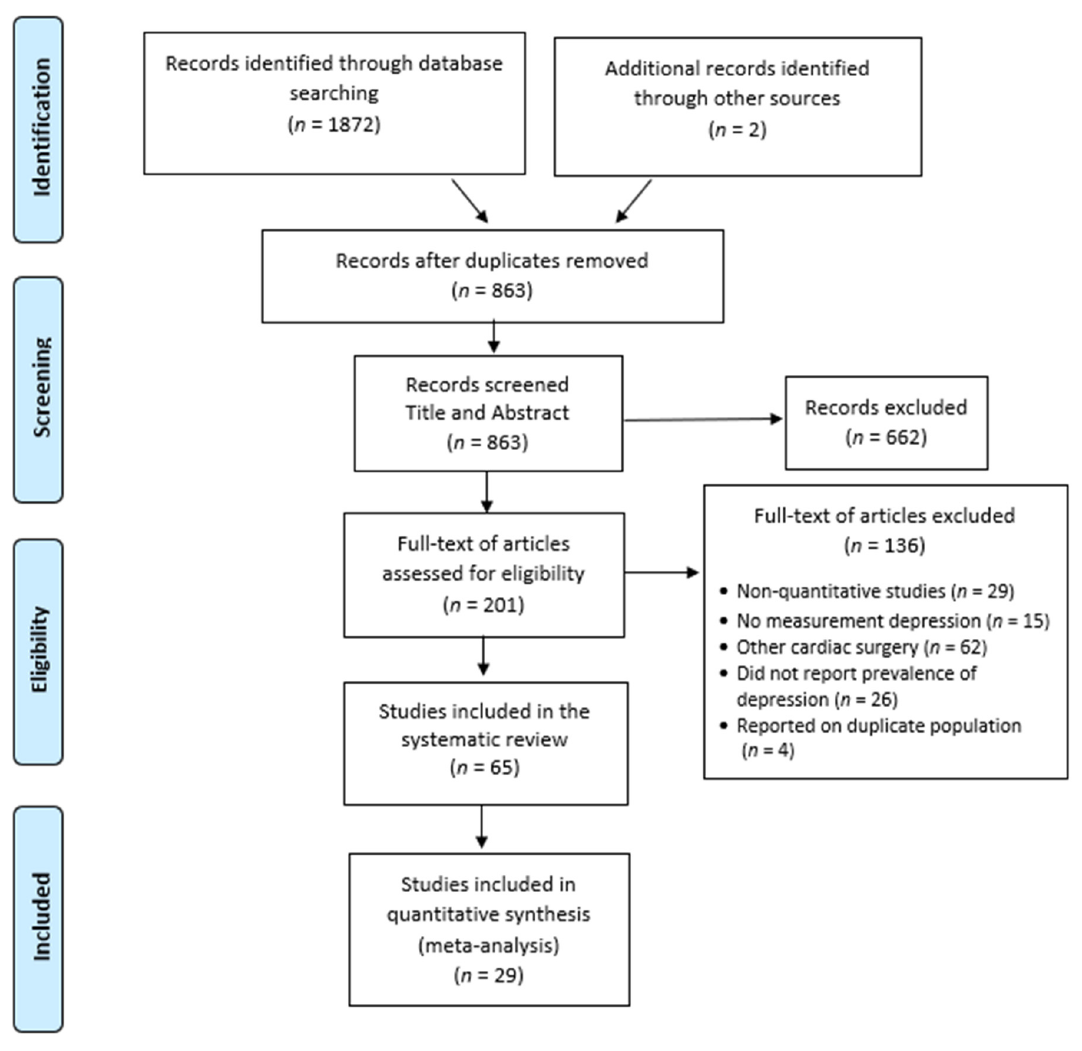
Figure 1. Preferred reporting items for systematic review and meta-analysis (PRISMA) flow-chart of included studies.